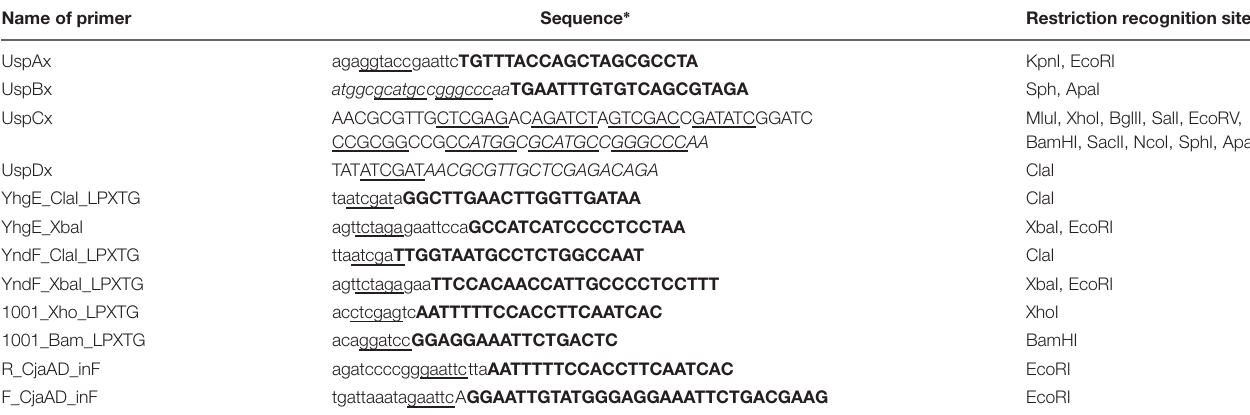
TABLE 2 | Oligonucleotides used in this